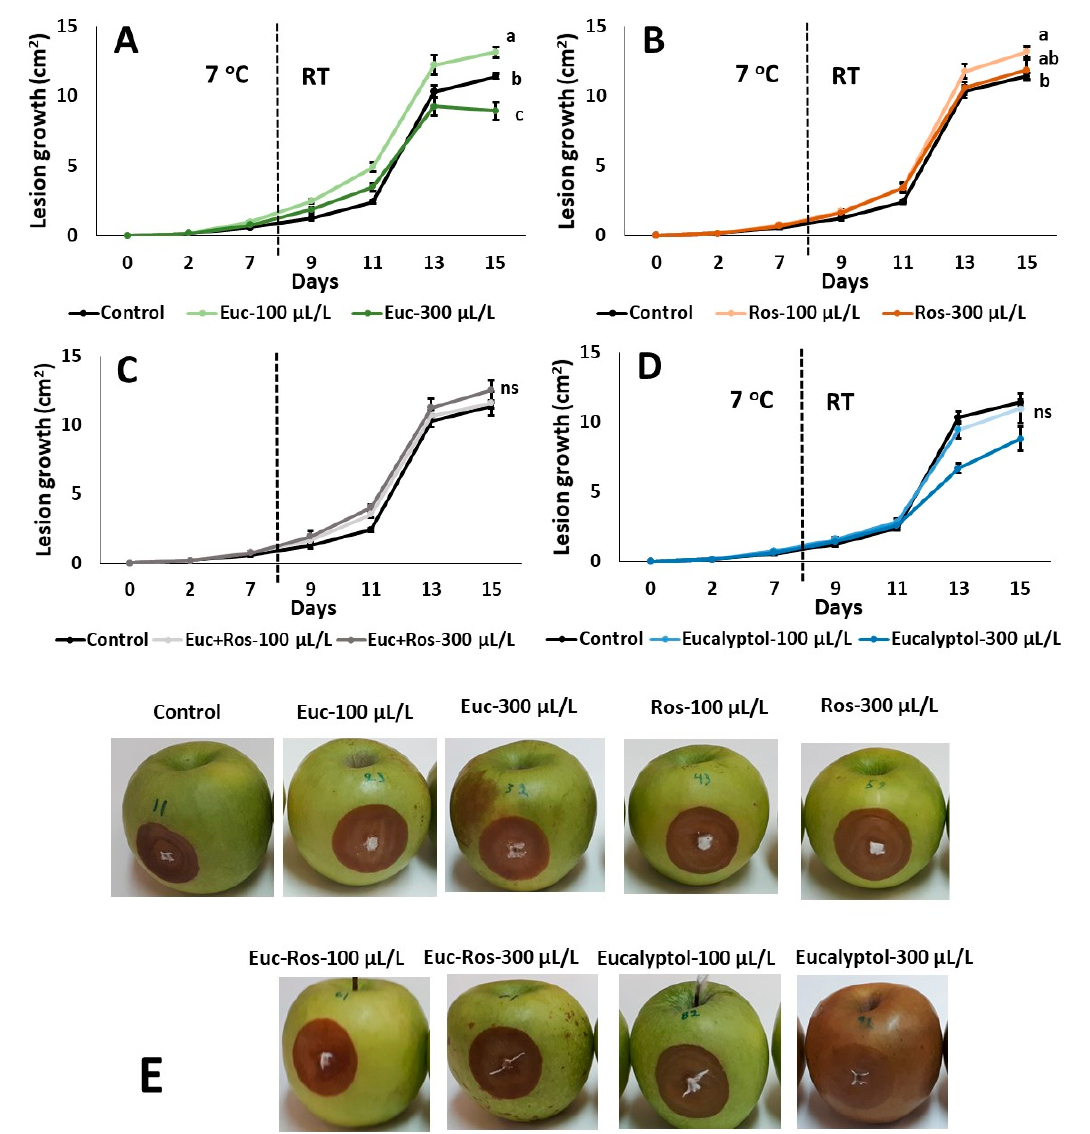
Figure 4. Effects of ( A ) eucalyptus EO (Euc), ( B ) rosemary EO (Ros), ( C ) their 50:50 mixture (Euc + Ros) and ( D ) eucalyptol on lesion growth of P. expansum grown on apple fruits stored at 7 °C for 8 days and subsequently at RT up to 15 days. Significant differences ( p < 0.05) among treatments are represented with different Latin letters; ns indicates no significant differences among the treatments, on the last day. ( E ) Representative image is also presented.